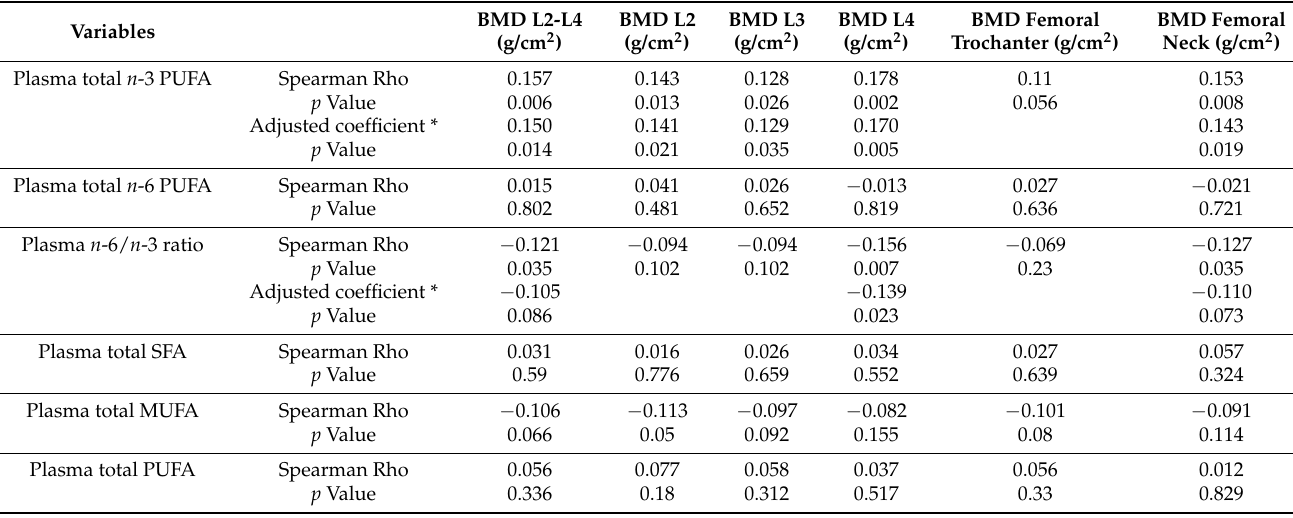
Table 9. Bivariate and partial correlations between plasma fatty acids and bone mineral density at either the lumbar spine or the